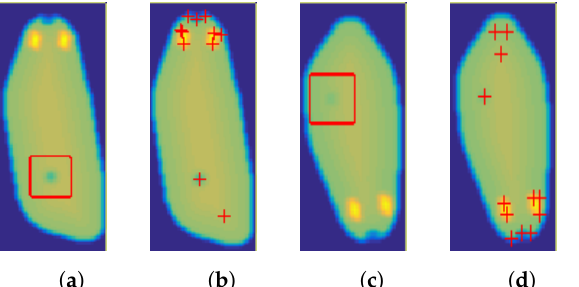
Figure 10. The results of Harris corner detector ( b , d ) on the simulated images ( a , c ) in the ( a , b ) 7th and ( c , d ) 19th frame of simulation. The trace is marked with a red rectangle and the detected corners are marked with red